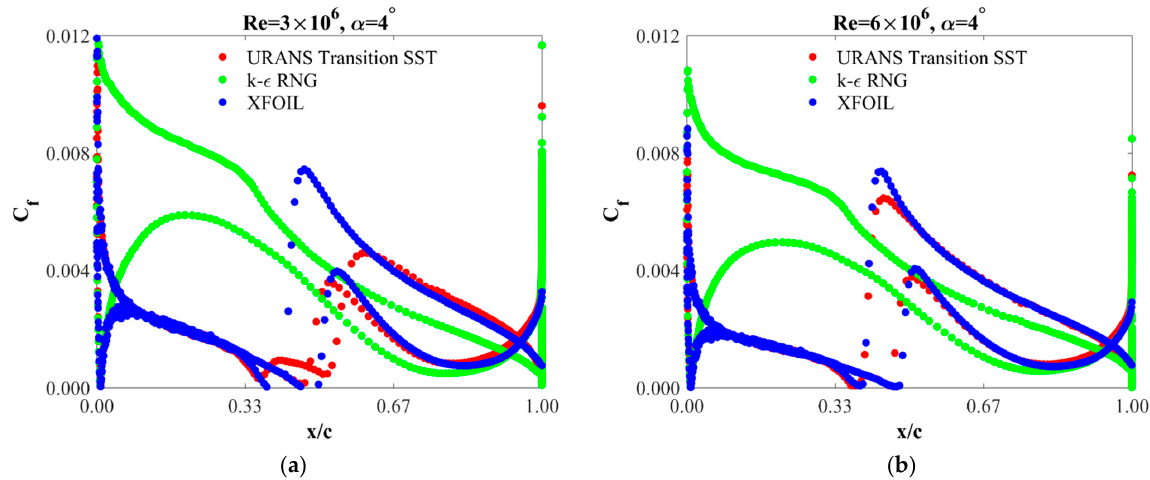
Figure 12. Skin friction coefficient at the angle of attack of 4 ◦ for two Reynolds number of 3 × 10 6 ( a ) and 6 × 10 6 ( b ). The results are given for three numerical approaches: ANSYS Fluent code together with the URANS method; the k- ε RNG turbulence model; the XFOIL code.